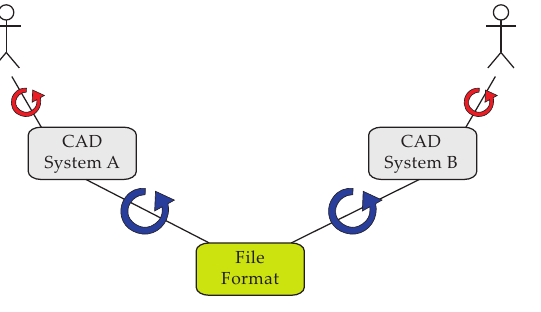
Figure 3. The information flow between two CAD systems using one file format contains two interface points (circular arrows) in which information needs to be converted, both between human users and information systems (in red) and among information systems (in